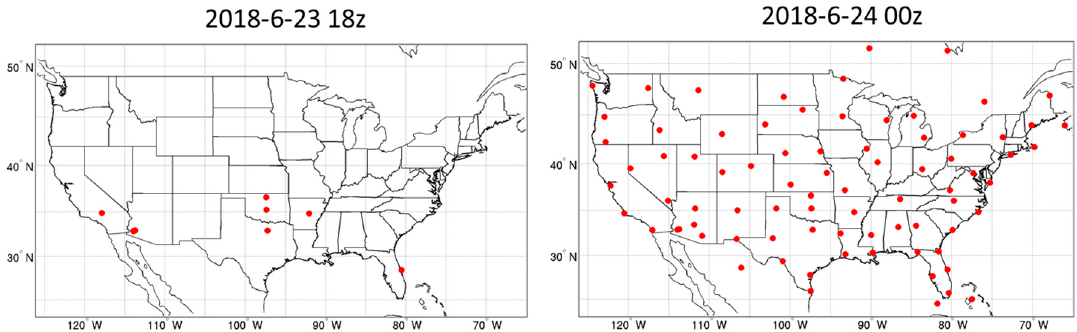
Figure 7. The locations of radiosonde stations at 1800 UTC 23 June and 0000 UTC 24 June, 2018.